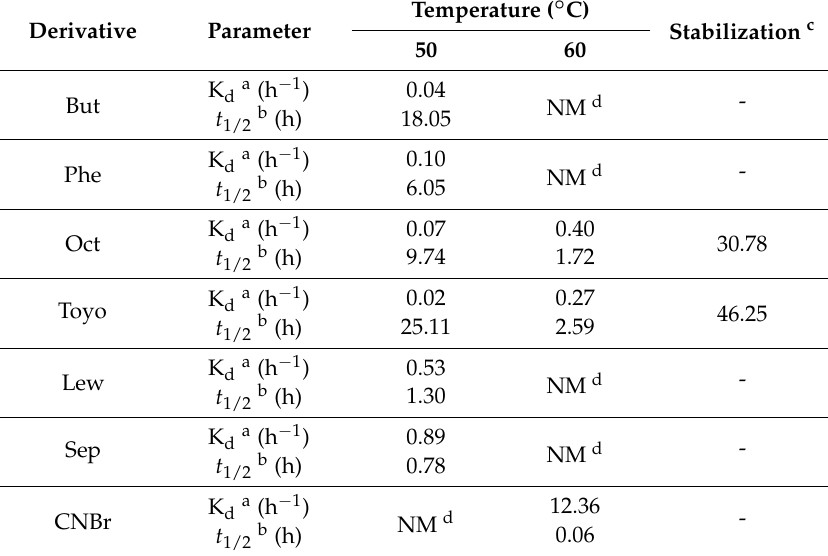
Table 2. Thermal parameters of Penicillium sp. (CBMAI 1583) lipase derivatives.